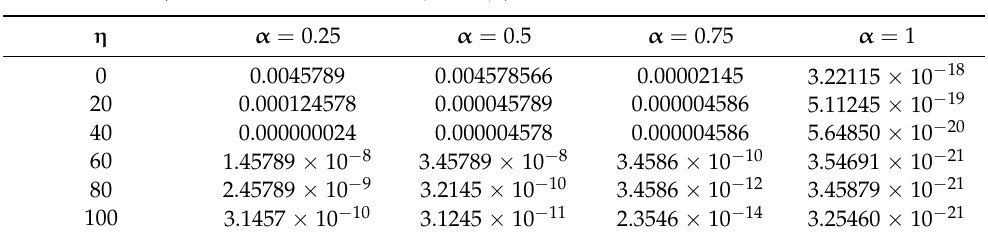
(cid:17)(cid:12) (cid:12) (cid:12) .